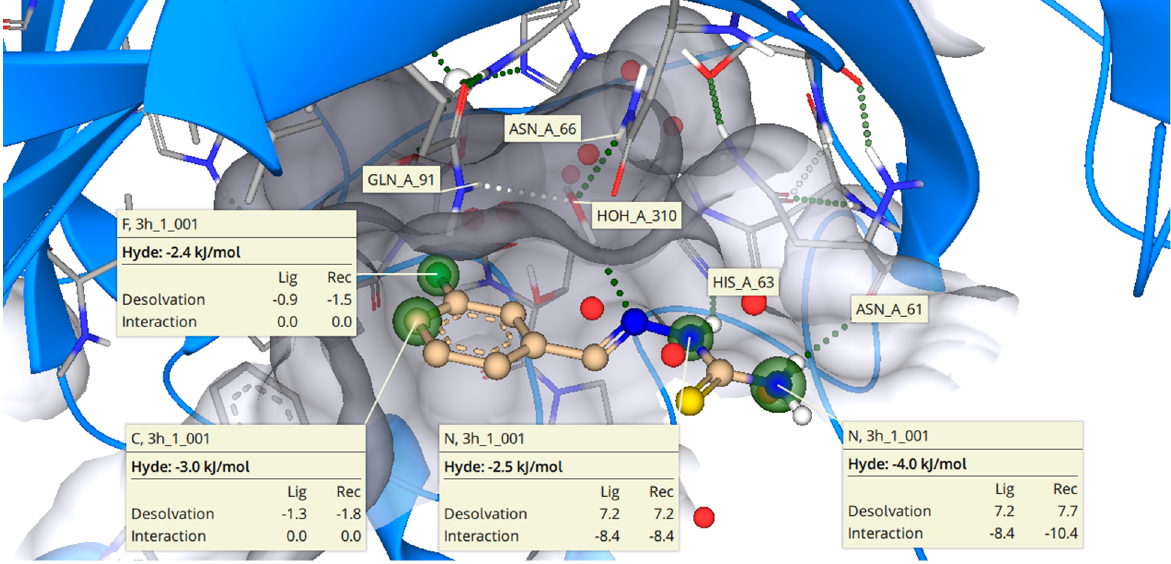
Figure 3. Putative binding mode of 3h (most potent compound, in peach color) in the active site of b -CA II (amino acid residue in grey color). The red-colored coronas depict unfavorable features, whereas green-colored coronas indicate favorable contributions and colorless coronas show no contribution from the structural components.